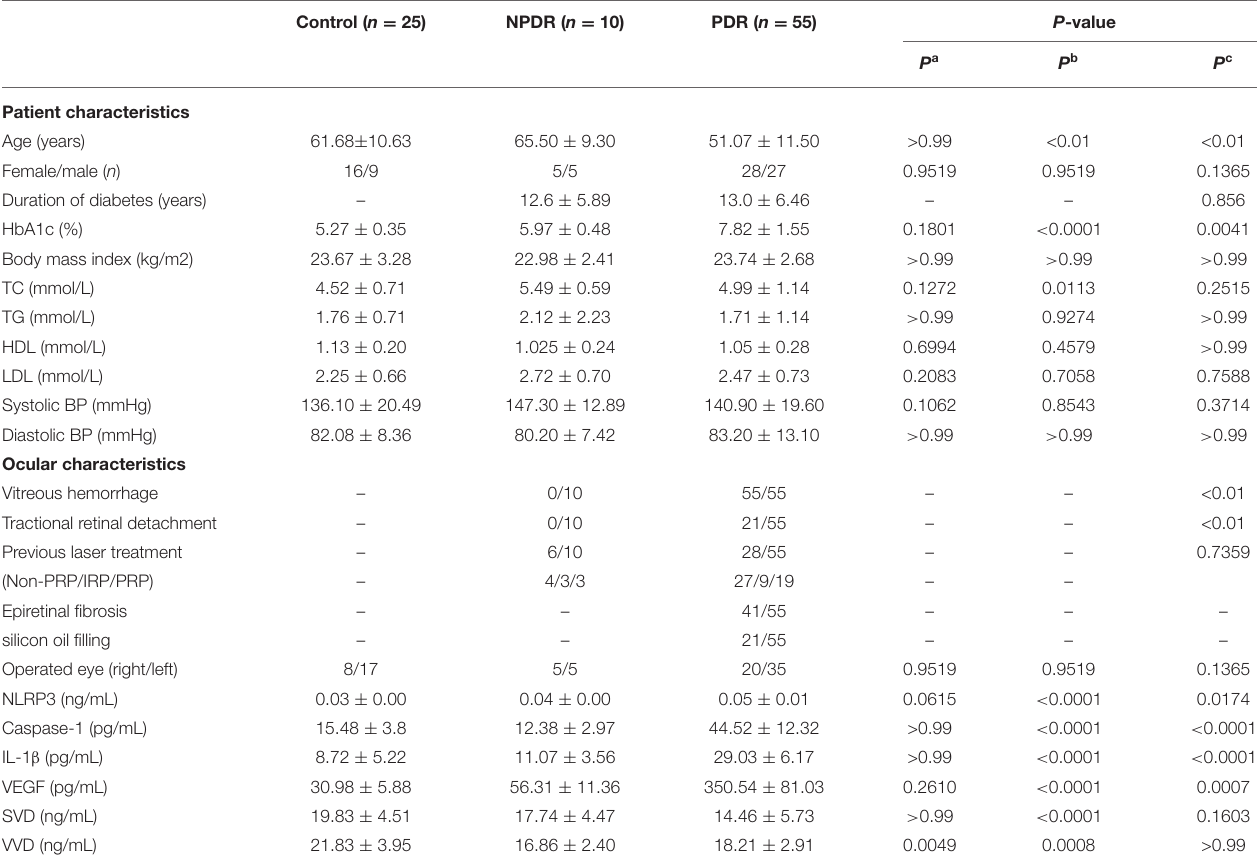
TABLE 1 | Systemic and ocular characteristics of participants. Control ( n = 25) NPDR ( n = 10) PDR ( n = 55) P -value